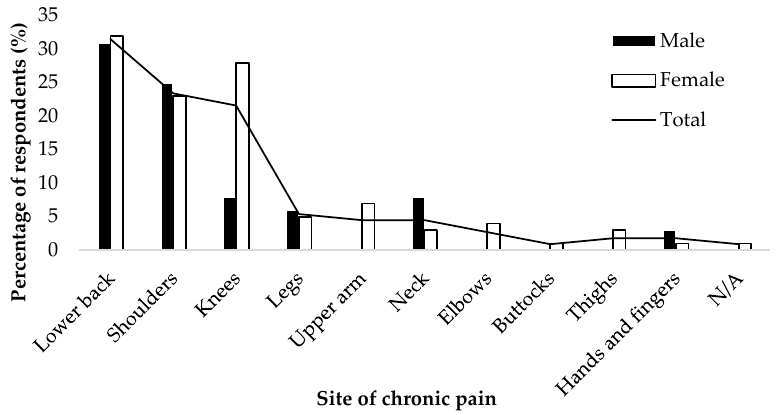
Figure 1. Percentage of chronic pain according to anatomical sites. Differences between the sexes in daytime activities are shown in Table 3. Out of all the male participants, 69% performed farm work each day, 11% performed indoor work, and 19% did not work. Out of the female participants, 35% performed farm work each day, 9% performed indoor work, 8% performed household work, and 48% did not work. Statistical analysis showed that more males than females were engaged in farm work dur- ing daytime ( p < 0.001). On the other hand, more females than males did little or no activity during daytime ( p < 0.001). These results suggest that males were more active during day- time and were more likely to be outdoors than females. Table 3. Characteristics of the individual daytime activities of the study subjects between males and females.